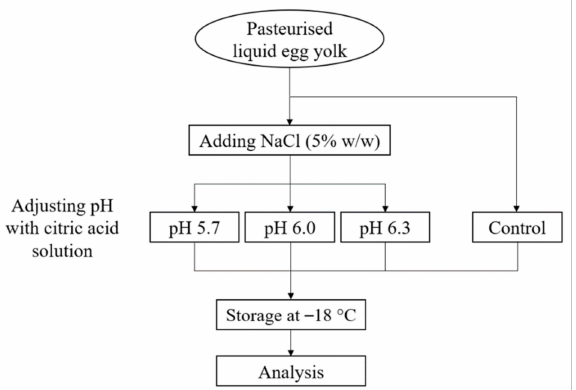
Figure 1. Flowchart of the